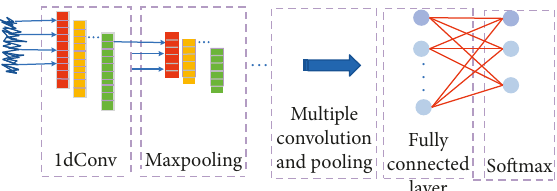
Figure 2: Convolutional neural network structure